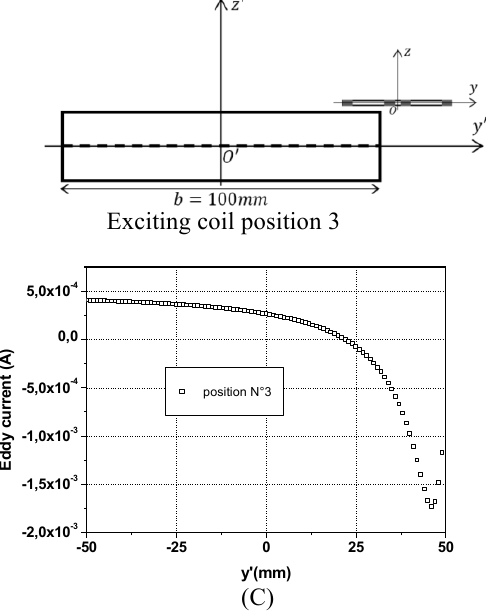
Figure 6 (C): Induced currents corresponding to the case of exciting coil position 3 as shown in the previous figure at the center of the The corresponding component of 𝐵 ! double rectangular coil is given in figure 7. We note that the variation curve of 𝐵 is clearly antisymmetric, and cancels at ! the center of the plate. The edges of the plate are clearly